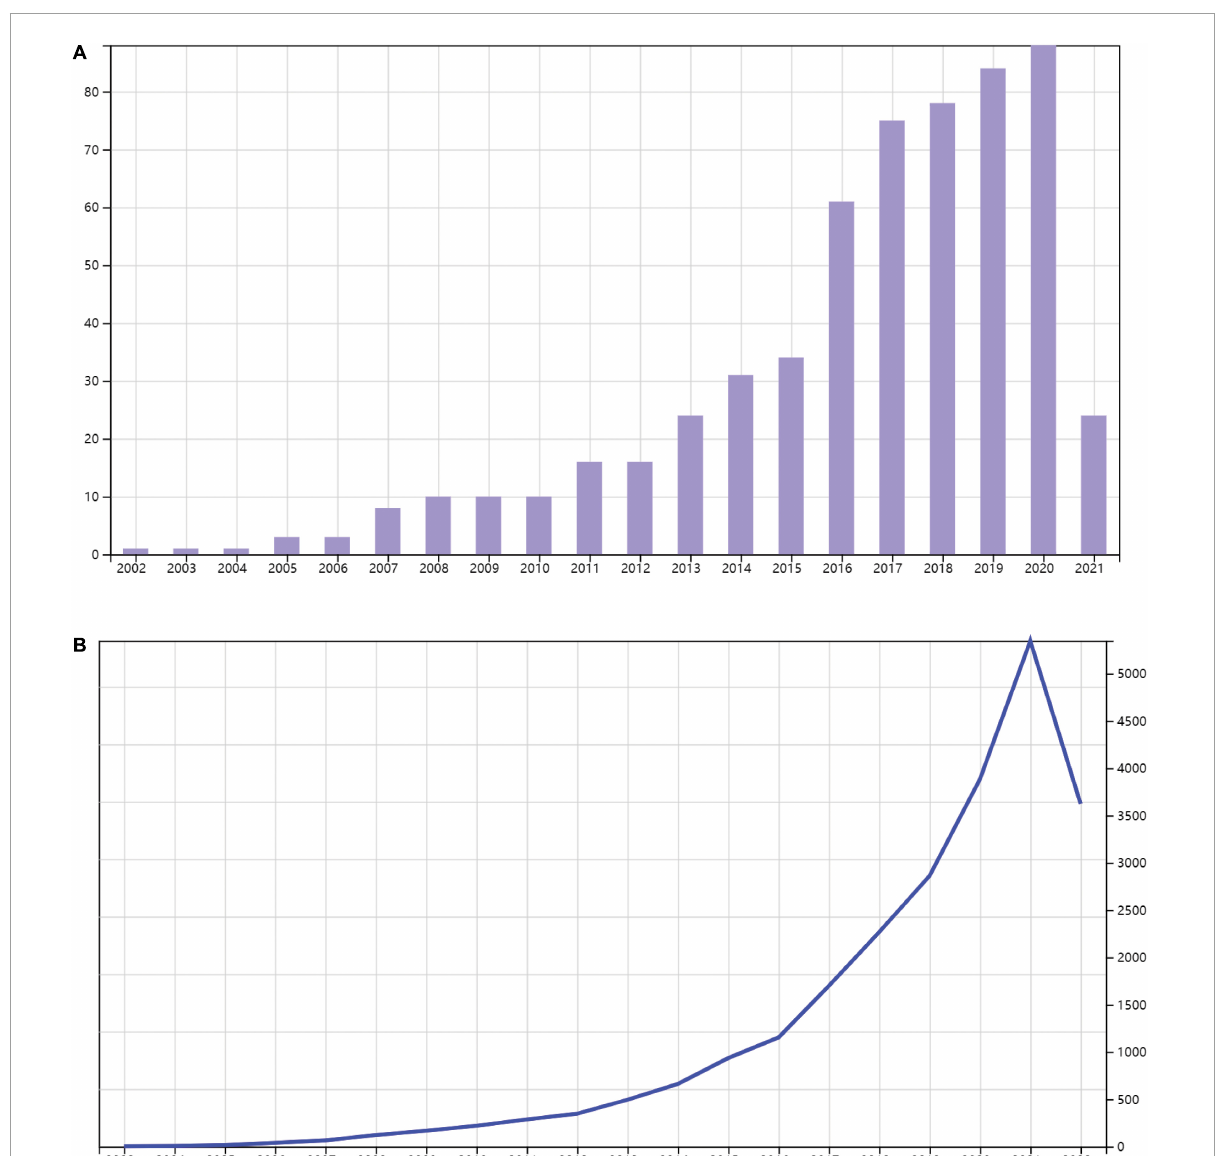
FIGURE1 Trends in publications of inflammation related to diabetic cardiomyopathy (DCM) research. Timeline of publications (A) and citations (B) on inflammation related to DCM.